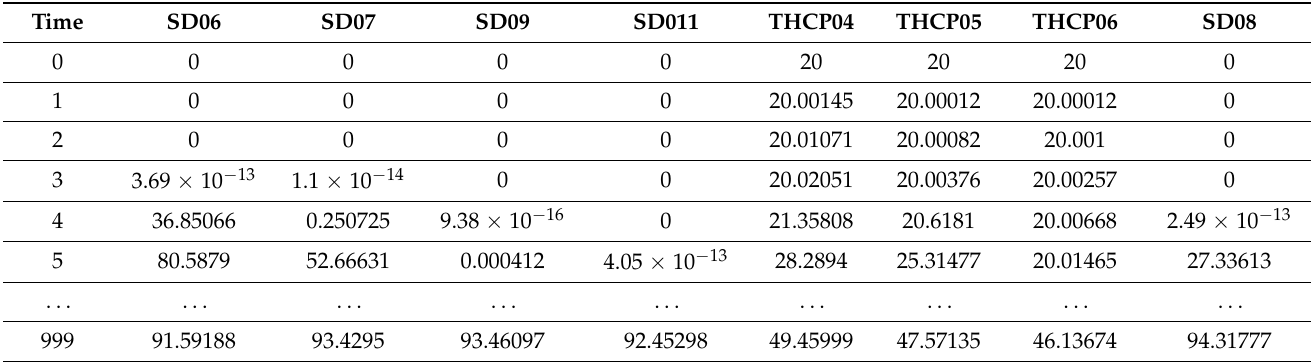
Table 4. Experimental parameter settings.